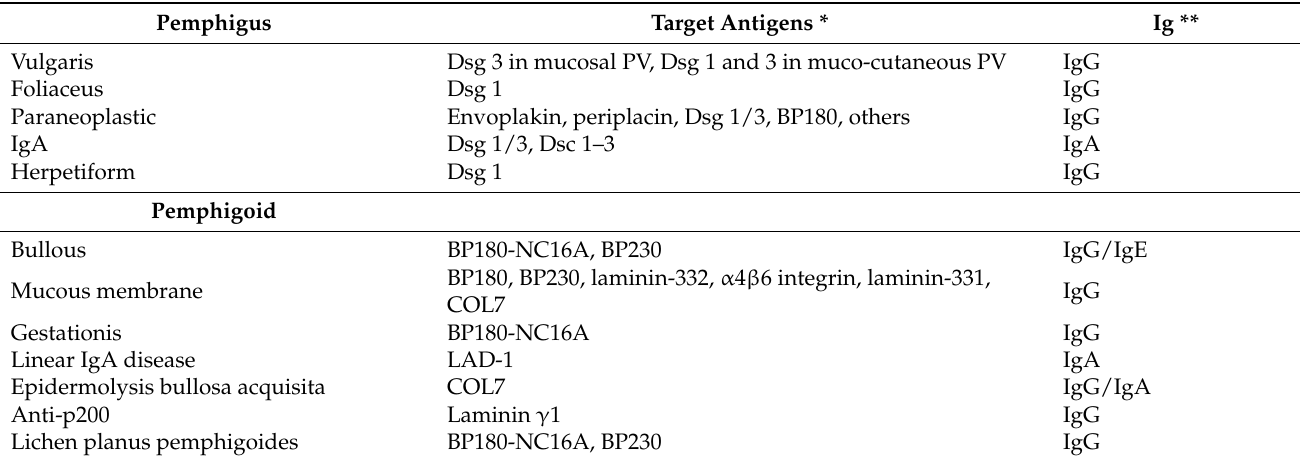
Table 1. Main autoantigens in pemphigus and